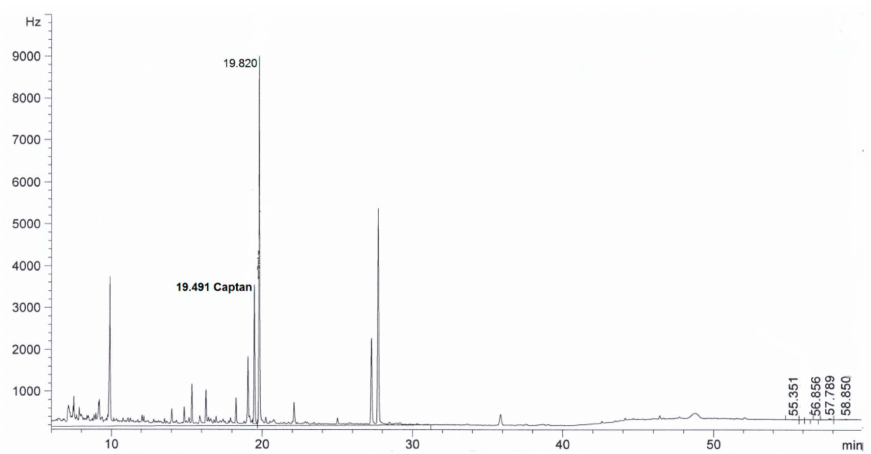
Figure 7. The chromatogram (GC- µ ECD) of industrial wastewater with the clean-up step using the dSPE (1 g Florisil ®